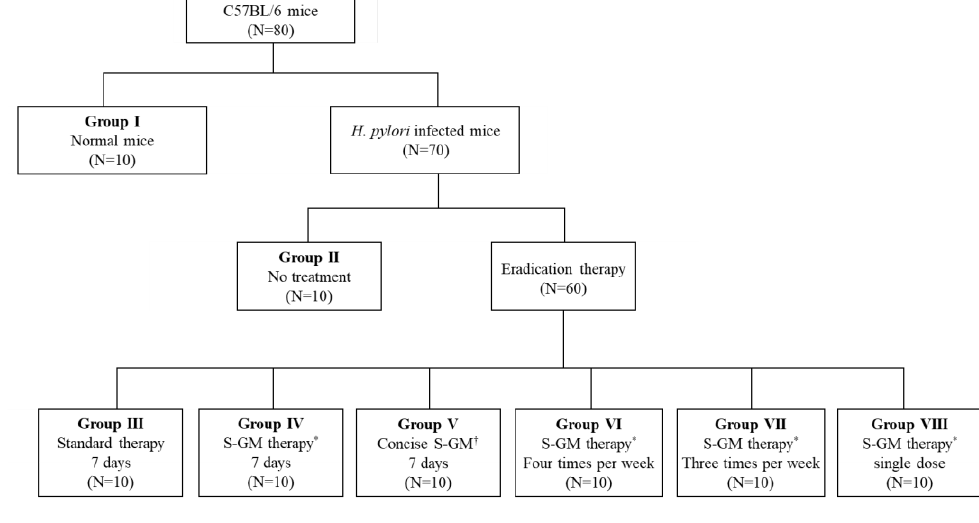
Figure 4. Flow chart for study design . * S-GM therapy, amoxicillin (14.25 mg/kg), gentamicin- intercalated smectite hybrid (S-GM) which emitted 8 mg/kg of gentamicin and omeprazole (138 mg/kg); † Concise S-GM therapy, gentamicin-intercalated smectite hybrid (S-GM) which emitted 8 mg/kg of gentamicin and omeprazole (138